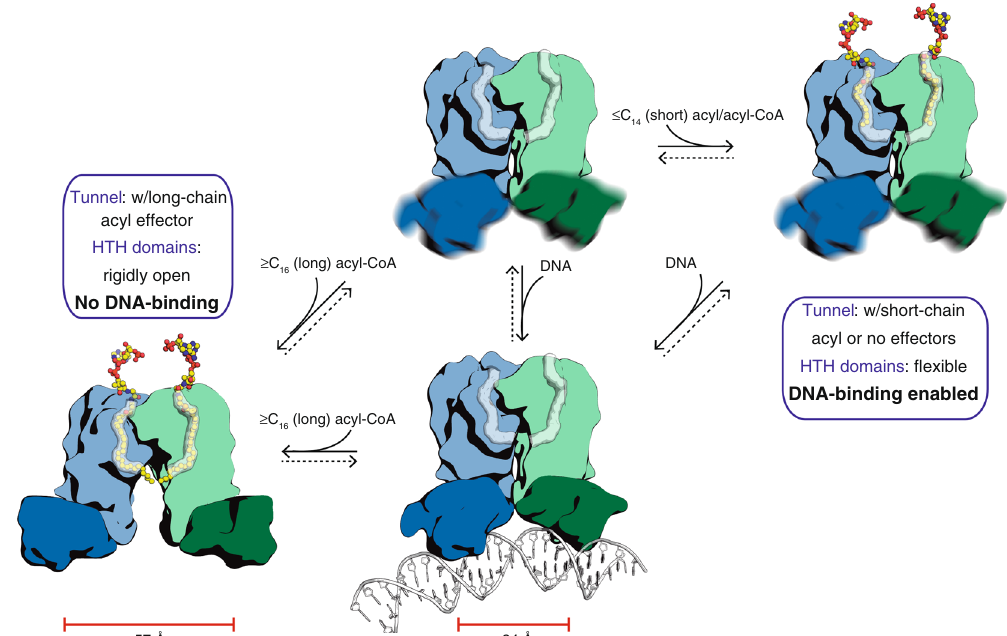
Fig. 7 FasR-mediated long acyl-CoA sensing and response mechanism. The model combines information from the three crystal structures presented in this report (FasR Δ 33 -C 14 , FasR Δ 33 -C 20 -CoA and FasR – DNA complexes). A free structure of FasR with no bound effectors nor DNA has not been determined experimentally, and is not currently known whether it builds up to detectable concentrations within the living cell. The dotted arrows re fl ect plausible equilibria. See Supplementary Movie 3 to better grasp the anticipated